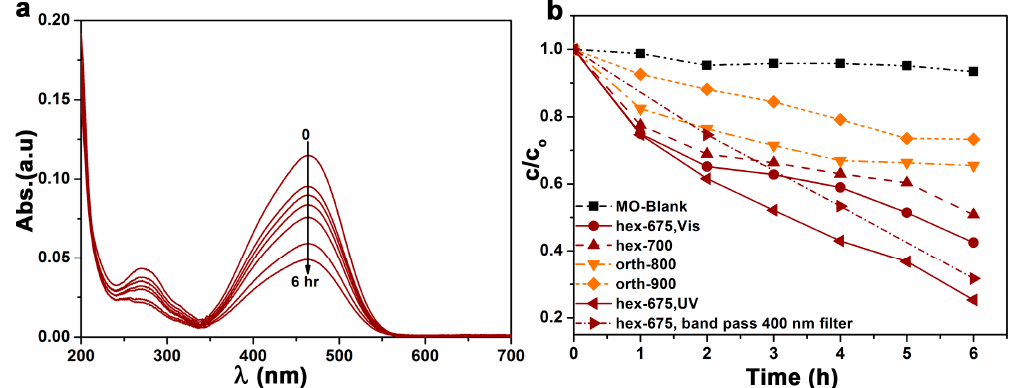
Figure 6. Photocatalytic degradation tests of methyl orange (MO): ( a ) The loss of absorbance at 464 nm using hex ‐ 675 YFeO 3 and ( b ) comparison of the normalized concentration changes over the different YFeO 3 samples and different conditions of illumination for hex ‐ 675. Light source: 150 W Xe arc lamp with cut ‐ off filter λ > 420 nm.